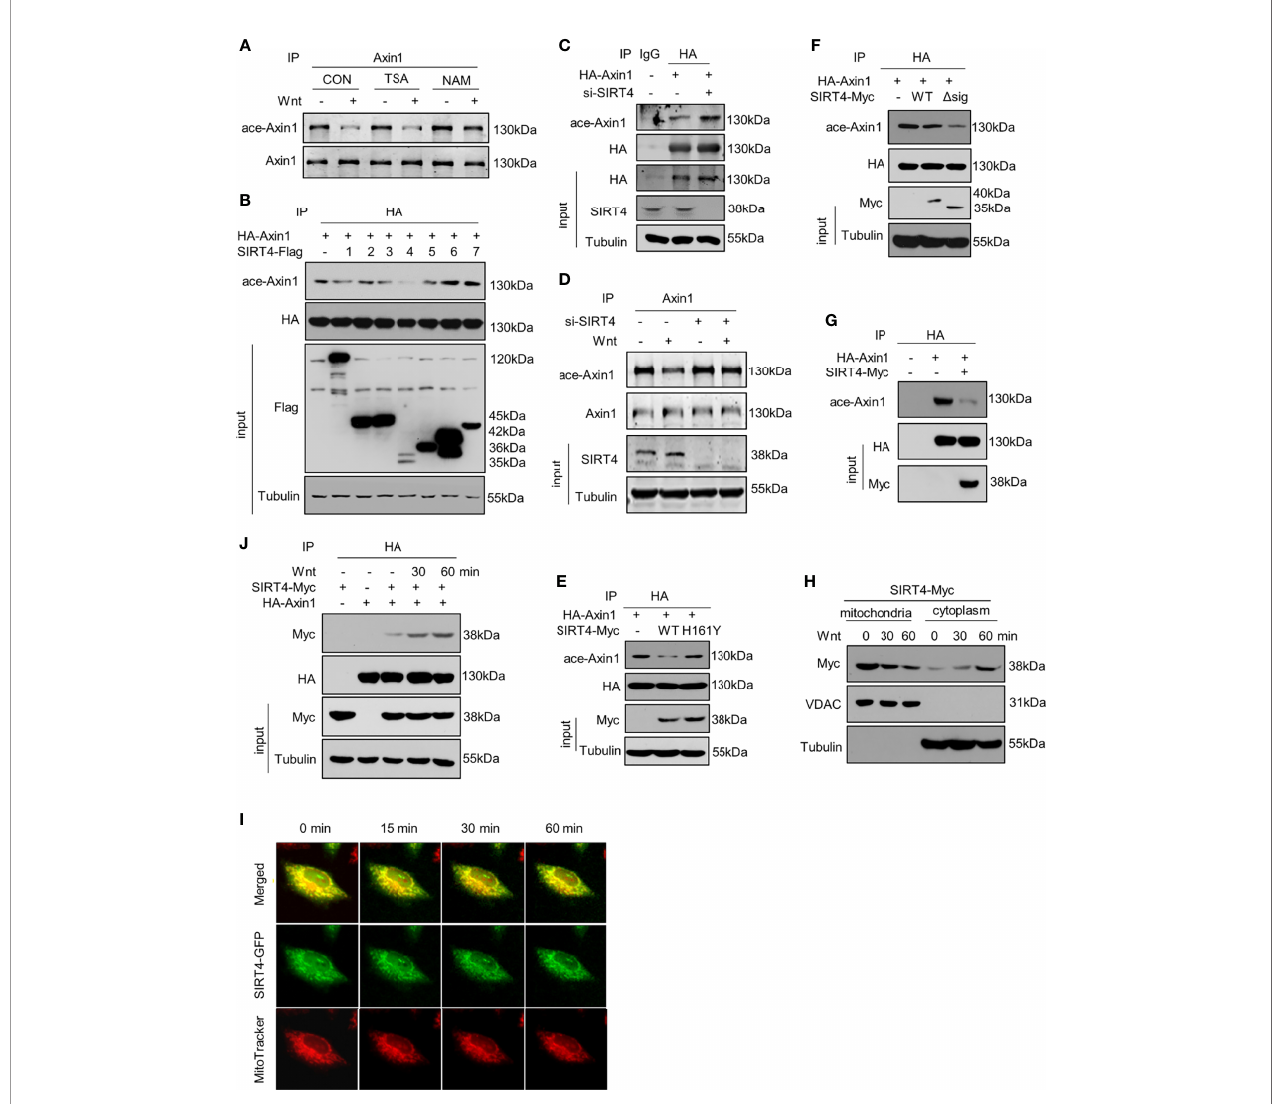
FIGURE 2 | SIRT4 translocates to the cytoplasm and regulates the acetylation levels of Axin1 (A) HEK293T cells overexpressing HA-Axin1 were treated with the HDAC inhibitor TSA (2 m M) or SIRT inhibitor NAM (5 mM) for 2 hour, followed by treatment with Wnt3a-conditioned medium for 30 minutes. Stimulated lysates were subjected to immunoprecipitation using an Axin1 antibody and were subjected to SDS-PAGE followed by western blot analysis using the indicated antibodies. (B) HA-Axin1 with/without Flag-tagged sirtuins (1-7) were overexpressed in HEK293T cells, HA-Axin1 was immunoprecipitated, and the acetylation levels of Axin1 were analyzed by western blot. Tubulin protein levels were used as loading control. (C) HA-Axin1 with/without siSIRT4 RNA were overexpressed in HEK293T cells. HA-Axin1 was immunoprecipitated with anti-HA, and the acetylation levels of Axin1 were analyzed by western blot. Tubulin protein levels were used as loading control. (D) Immunoprecipitation analysis of Axin1 acetylation in HEK293T cells transfected with siSIRT4, followed by western blot analysis using the indicated antibodies after Wnt3a-conditioned medium stimulation. Tubulin protein levels were used as loading control. (E) HA-Axin1 was coexpressed with SIRT4-Myc or SIRT4-H161Y-Myc in HET293T cells for 48h. HA-Axin1 was immunoprecipitated with anti-HA, and the acetylation levels of Axin1 were analyzed by western blot. Tubulin protein levels were used as loading control. (F) HA-Axin1 was coexpressed with SIRT4-Myc or SIRT4- D sig-Myc in HET293T cells for 48 h. HA-Axin1 was immunoprecipitated with anti-HA, and the acetylation levels of Axin1 were analyzed by western blot. Tubulin protein levels were used as loading control. (G) HA-Axin1 and SIRT4-Myc were overexpressed respectively in HET293T cells. The proteins were puri fi ed 48 h later, an in vitro deacetylation assay was performed and the acetylation levels of Axin1 were analyzed by western blot. (H) HEK293T cells transfected with SIRT4-Myc for 48 h were treated with Wnt3a-conditioned medium for indicated times and fractioned into cytoplasmic and mitochondrial fractions. The cell fractions were then analyzed by western blot with the indicated antibodies. VDAC was used as a loading control for mitochondria proteins. Tubulin was used as a loading control for cytoplasm proteins. (I) Hela cells were transfected with SIRT4-GFP, and 48 hours later, the cells were stained with MitoTrackerer ™ Red CMXRos for 10 min and then treated with Wnt3a-conditioned medium for the indicated time. For the same scope, both green (SIRT4) and red (mitochondria) fl uorescence were captured with a Leica Microsystem at the indicated time points after treatment with Wnt3a-conditioned medium. (J) HA-Axin1 was coexpressed with or without SIRT4-Myc in HET293T cells for 48 h. Some cells were treated with Wnt3a-conditioned medium as indicated. HA-Axin1 was immunoprecipitated with anti-HA, and the interaction between Axin1 and SIRT4 was detected by western